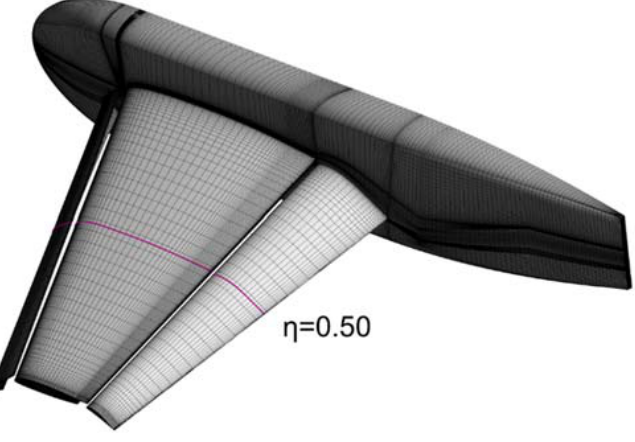
Figure 3. Surface grid of NASA Trap ‐ wing Configuration 8.